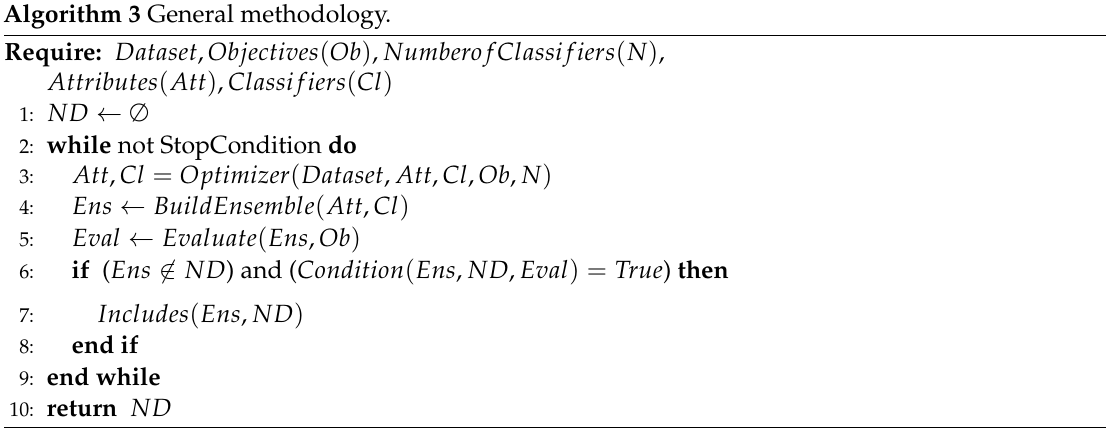
Algorithm 3 General